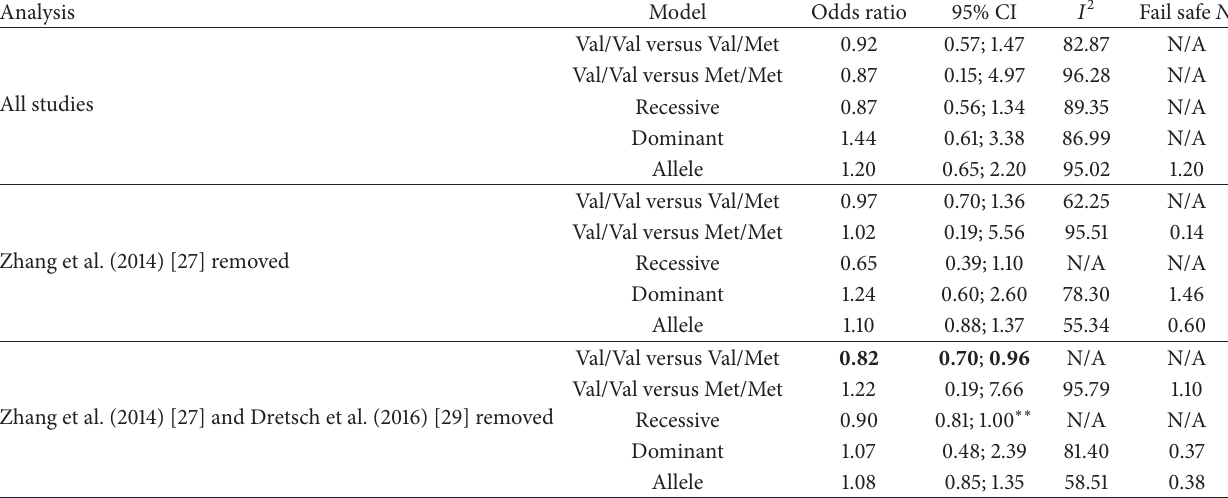
Table 6: Results of the overall meta-analysis including all studies and stepwise removal of Zhang et al. (2014) [27] and Dretsch et al. (2016) [29] in a random-effects model.